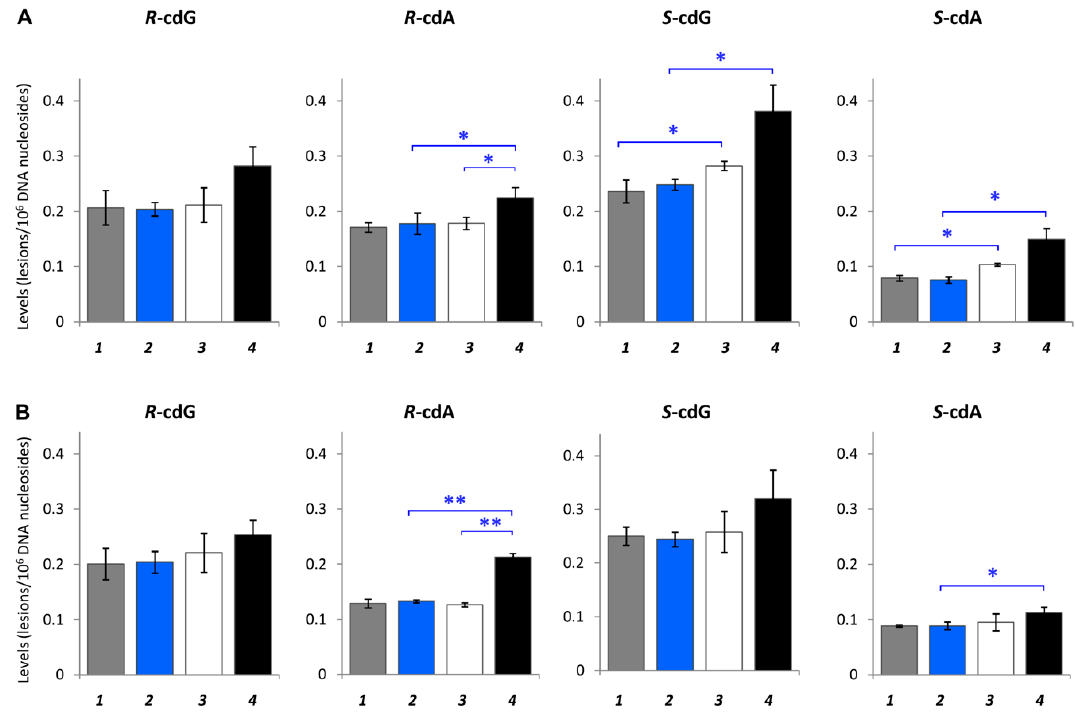
Figure 13. Levels of cPu lesions/10 6 nucleosides measured by LC–MS/MS in control severe combined immunodeficient (SCID) and tumor-bearing SCID mice. ( A ) Levels of R -cdG, S -cdG, R -cdA, and S -cdA lesions in genomic DNA isolated from the liver of control SCID mice (group 1 : 4 weeks old; group 2 : 17 weeks old) and tumor-bearing SCID mice (group 3 : 4 weeks old; group 4 : 17 weeks old). ( B ) Levels of R -cdG, S -cdG, R -cdA, and S -cdA lesions in genomic DNA isolated from the kidney of control SCID mice (groups 1 and 2 ) and tumor-bearing SCID mice (groups 3 and 4 ). * Denotes a statistically significant difference ( p < 0.05) and ** denotes a statistically significant difference p < 0.005 between the animal groups. From reference [140].